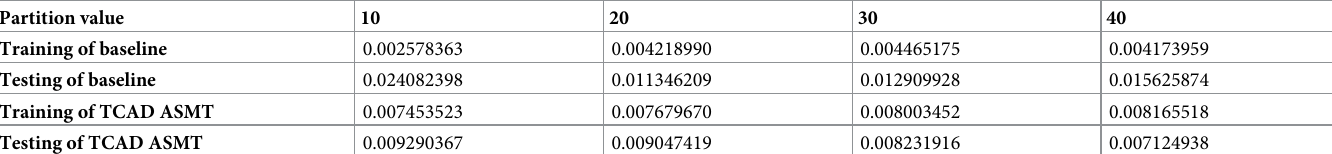
Table 4. MSE values of the training and testing of the 5-input dataset for the TCAD-labeled ASMT